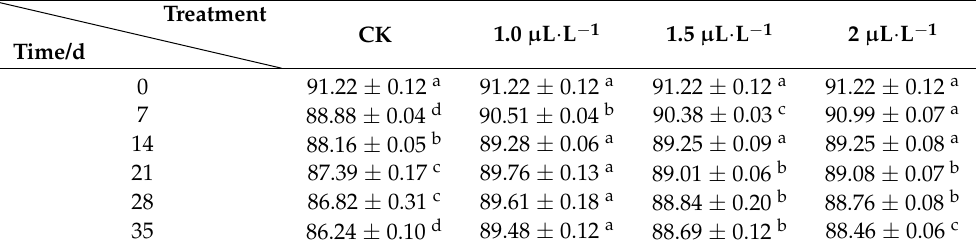
Table 1. Effect of 1-MCP on moisture content of root mustard.